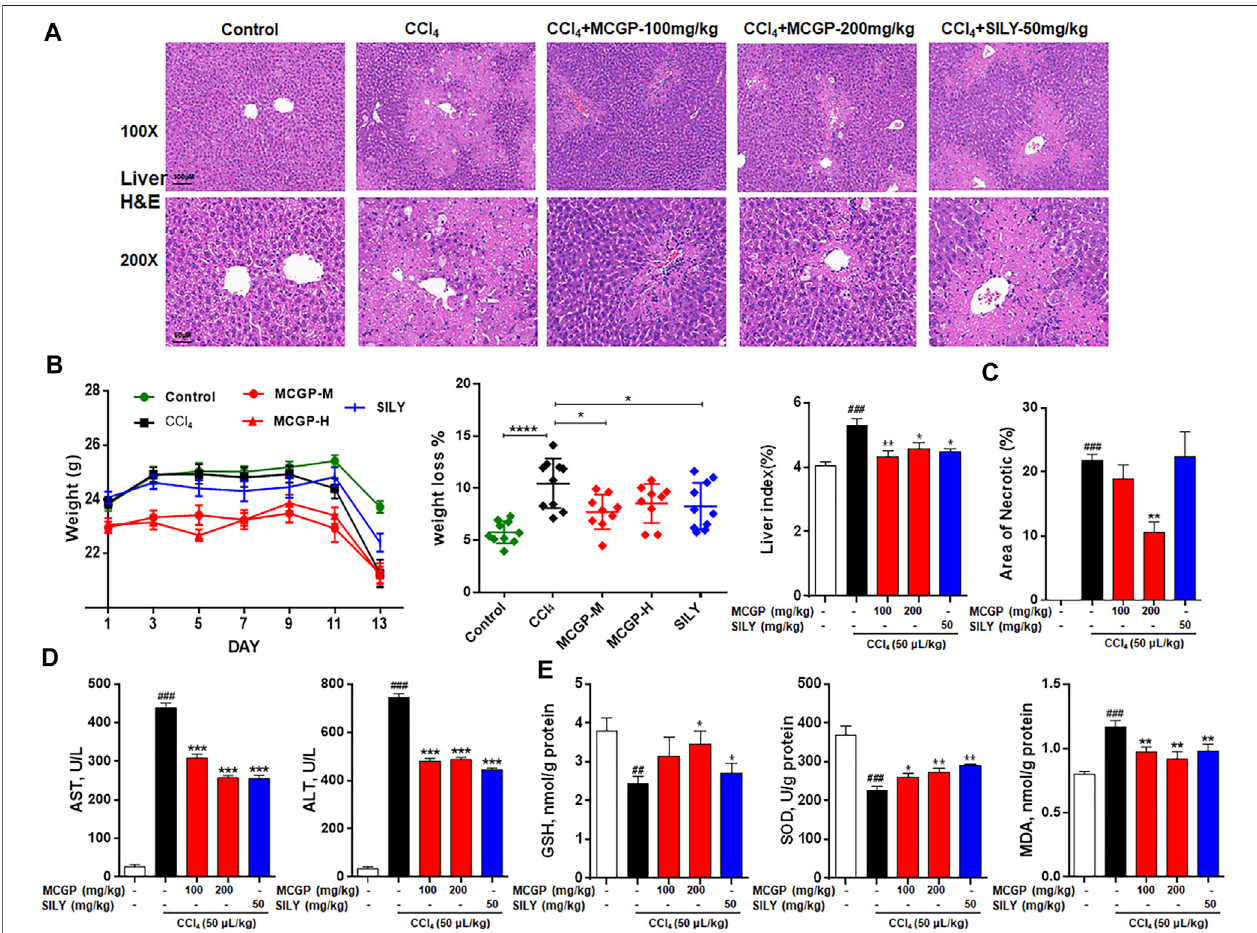
FIGURE 5 | MCGP treatment alleviated CCl 4 -intoxicated liver injury. (A) Liver histological observation. Mice were pretreated with vehicle or various dosages of MCGP (100or200 mg/kg) orpositivecontrolsilymarin(50 mg/kg) onceadayfor10days,andthen followedwithasingleintraperitonealinjection of1%CCl 4 (in oliveoil, 5 ml/kg) 1 h after the last MCGP administration. Typical images are chosen from each experimental group: Control, CCl 4 , MCGP-M + CCl 4 , MCGP-H + CCl 4 , SILY (silymarin + CCl 4 ) (n = 10). (B) Mice weight, weight loss, and liver index of each group. (C) Counted necrotic areas of each group (n = 3). (D) Serum ALT and AST activity. (E) LiverlevelsofGSH,MDAandSODineachgroup.Datawerepresentedasthemean±SEM.## p < 0.01,### p < 0.001vscontrol,* p < 0.05,** p < 0.01,*** p < 0.001 vs CCl 4